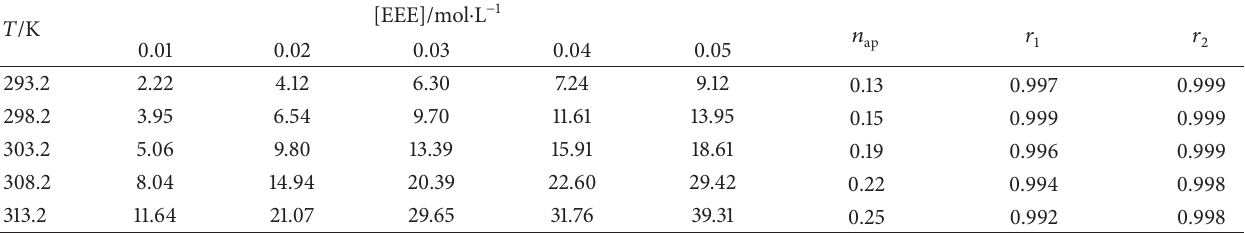
Table 2: 10 3 𝑘 /s − 1 varying with the different [EEE] at different obs